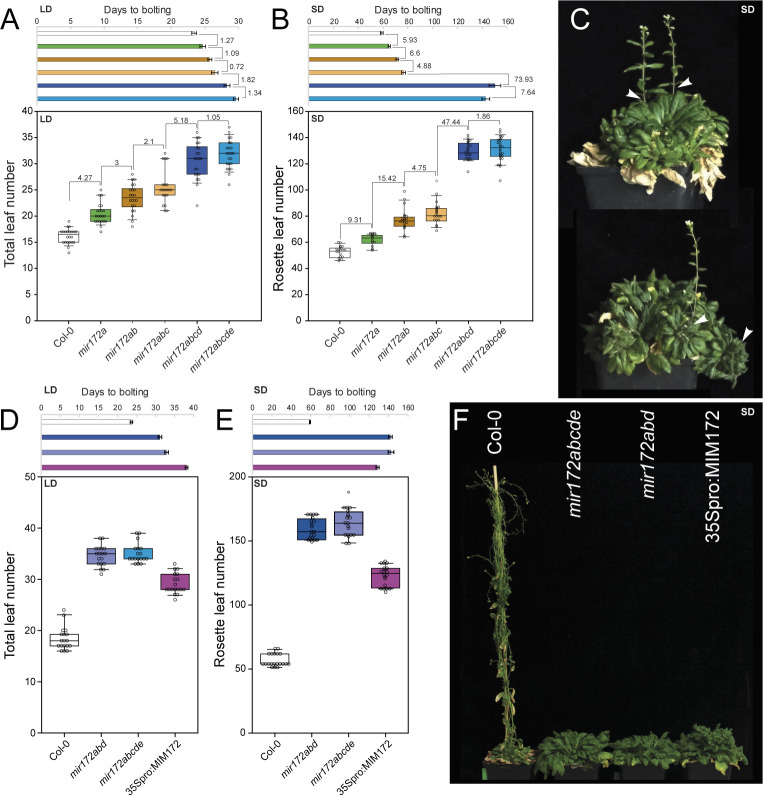
Flowering time of higher-order mir172 mutants in LDs and SDs.(A, B) Graphs depicting DTB and TLN or RLN of Col-0, mir172a-2, mir172a-2 b-3, mir172a-2 b-3 c-1, mir172a-2 b-3 c-1 d-3, and mir172a-2 b-3 c-1 d-3 e-1 mutant combinations in LD (A) and SD (B) conditions. The difference between the means of the indicated genotypes is shown above the box plots. Data underlying panels (A) and (B) are provided in S2 Data. (C) Photographs of mir172a-2 b-3 c-1 d-3 e-1 plants after approximately 6 months of growth under SD conditions. Plant initiated flowering shoots from axillary meristems (white arrowheads) rather than the primary meristem. (D, E) Graphs depicting DTB and total or RLN of Col-0, mir172a-2 b-3 d-2, mir172a-2 b-3 c-1 d-3 e-1 mutant combinations and 35Spro:MIM172 in LD (D) and SD (E) conditions. Data underlying panels (D) and (E) are provided in S2 Data. (F) A photograph of Col-0, mir172a-2 b-3 d-2, mir172a-2 b-3 c-1 d-3 e-1 mutant combinations and 35Spro:MIM172 grown under SD conditions. DTB, days to bolting; LD, long-day; RLN, Rosette leaf number; SD, short-day; TLN, total leaf number.